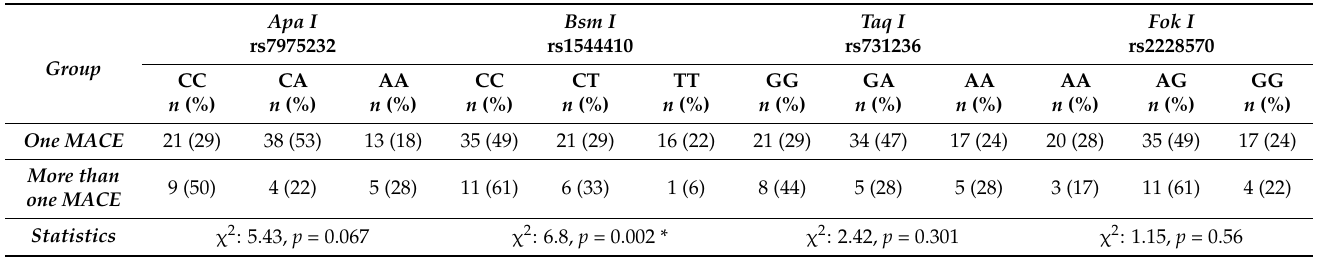
Table 7. Distribution of VDR gene genotypes among one MACE event and more than one MACE